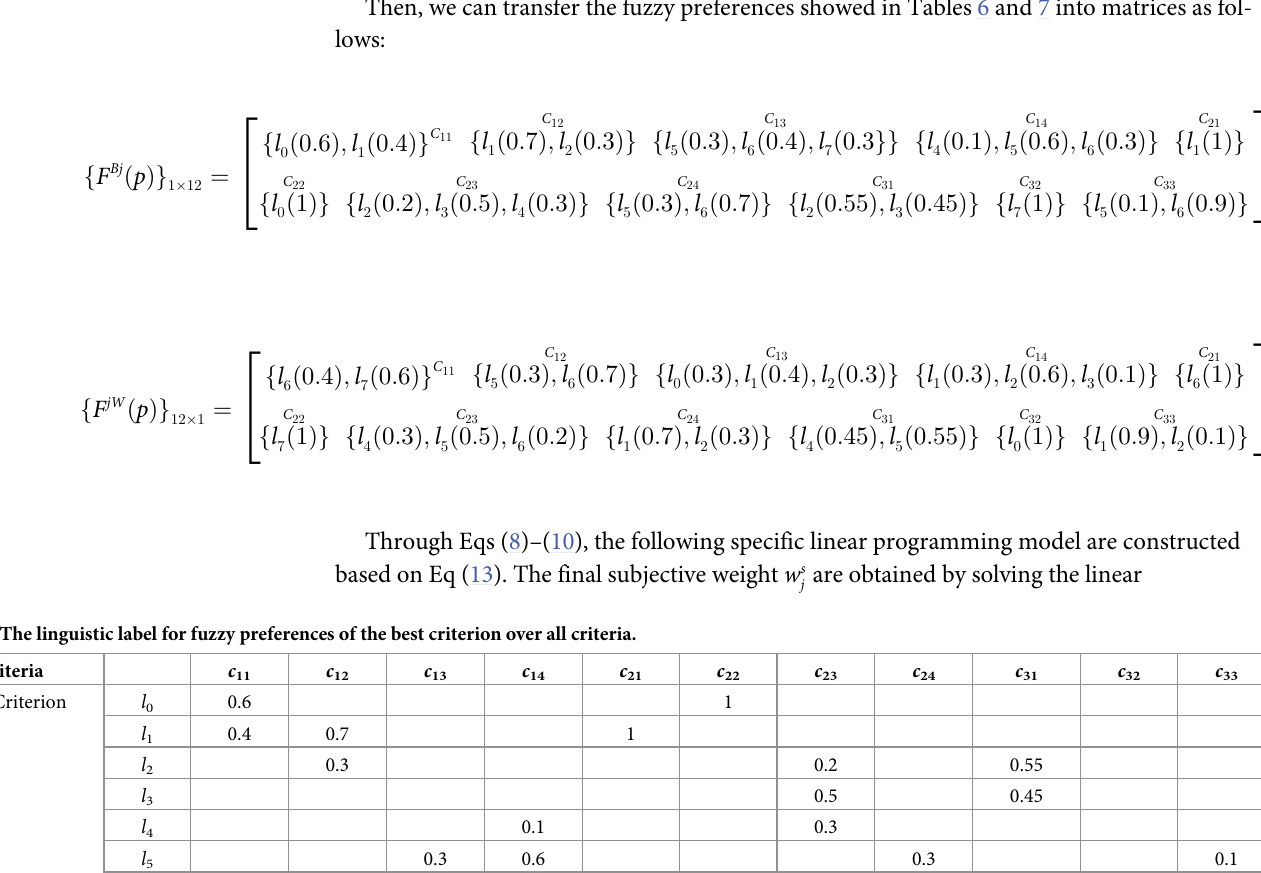
the following two matrices. the three DMs jointly executed the reference comparisons with PLTS after consultation, Tables 6 and 7 show the fuzzy preferences of Best-to-Others and Oth- ers-to-Worst based on Table 8. Then, we can transfer the fuzzy preferences showed in Tables 6 and 7 into matrices as fol- lows: